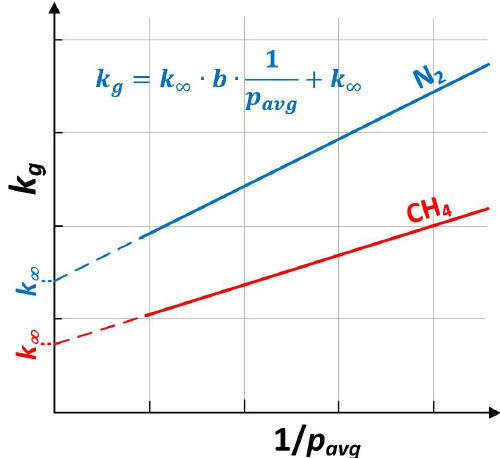
Figure 2. An example of the dependence of the permeability coefficient k g on the reciprocal average pressure 1/ p avg .